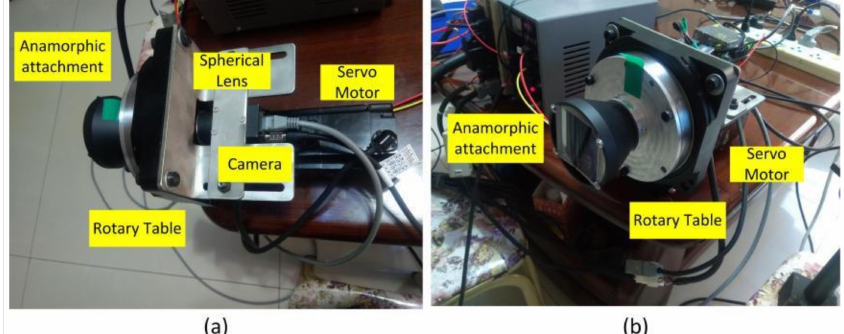
Figure 8. Anamorphic lens composed of a front anamorphic attachment and a rear spherical lens. The anamorphic lens was mounted on a rotary table which could rotate the anamorphic lens by − 90 ◦ along the optical axis. ( a ) Side view; ( b ) Front view.